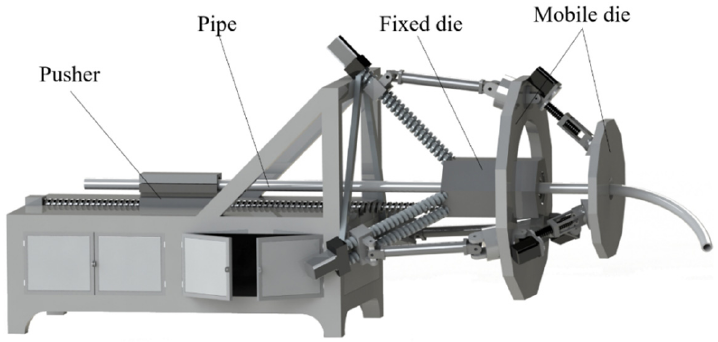
Figure 2. Whole structural design for free bending device.